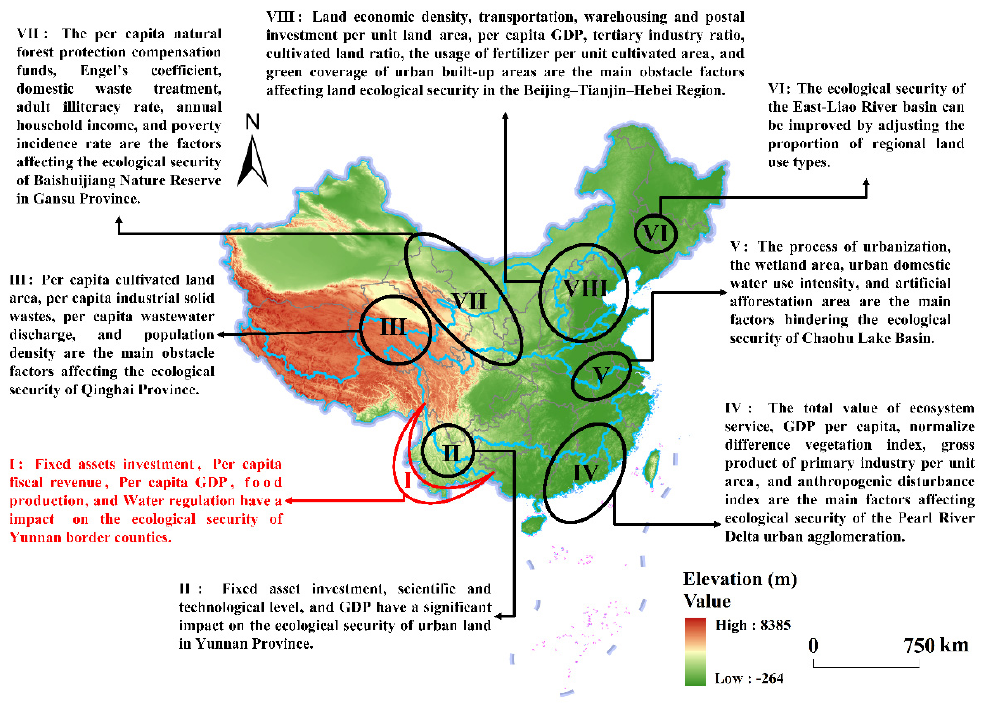
Figure 9. Spatial distribution of influencing factors of ecological security in China. Eight regions are labeled as follows: (I) Border areas in Yunnan Province, (II) Yunnan Province [73], (III) Qinghai Province [22], (IV) the Pearl River Delta Urban agglomeration [12], (V) the Chaohu Lake Basin [17], (VI) the East-Liao River basin [26], (VII) Gansu Province [74], (VIII) the Beijing–Tianjin–Hebei Re- gion [72]. Note: Map was created by authors using ArcGIS 10.7 based on the digital elevation model (DEM) data from the Resources and Environment Data Center of the Chinese Academy of Sciences (https://www.resdc.cn/, accessed on 4 January 2022).